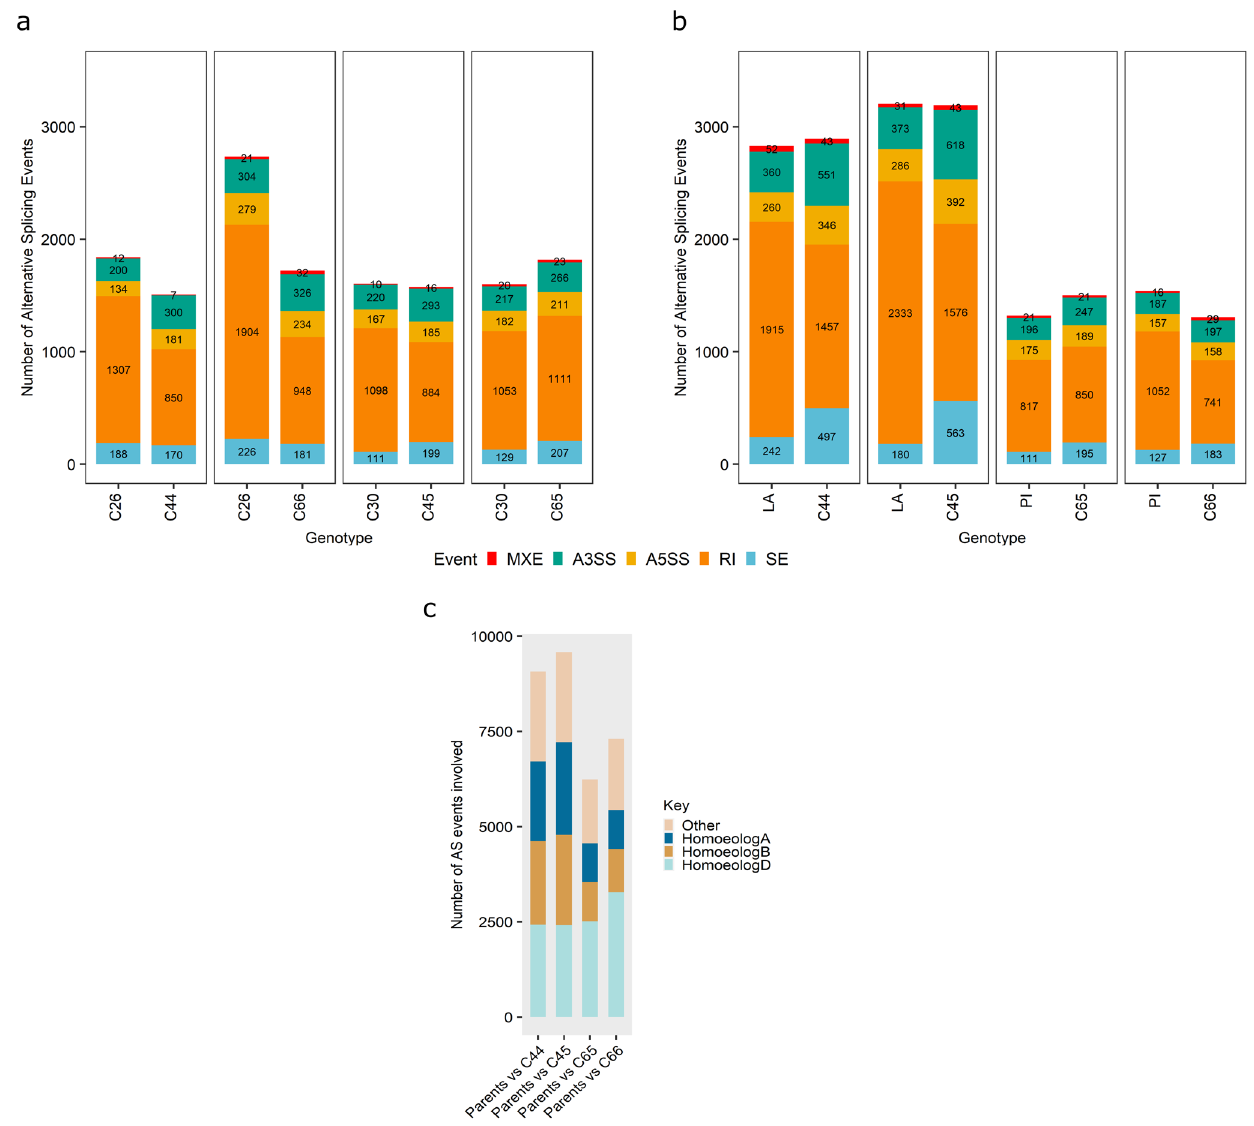
Fig. 10 Number of alternative splicing events detected in the diploid (C26, C30)/tetraploid (LA, PI) parents compared to the SHWs (C44, C45, C65, C66) in shoot tissue. ( a ) Diploid parent vs. SHW line; ( b ) Tetraploid parent vs. SHW. MXE mutually exclusive exons, A3SS alternative 3 ′ splicing,